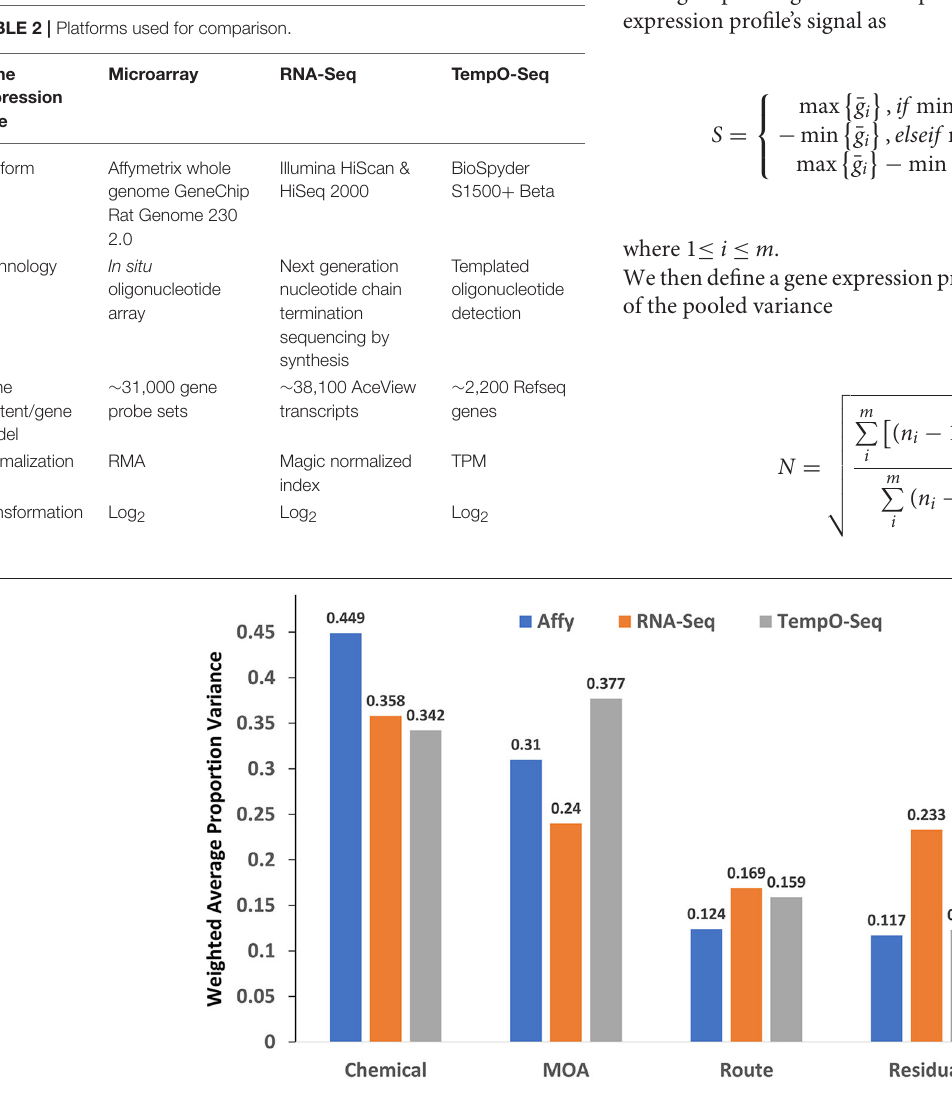
Frontiers in Genetics |